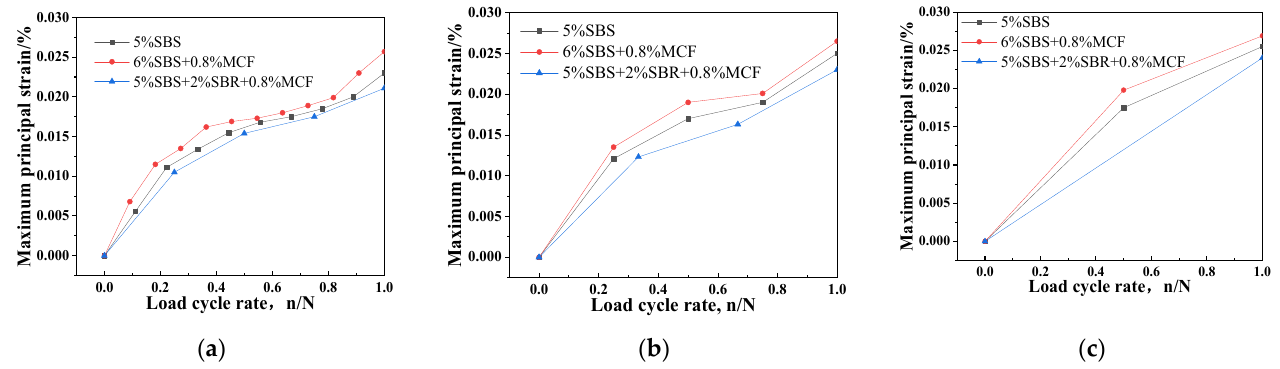
Figure 12. Relationship between maximum principal strain and loading cycle rate: ( a ) Relationship curves under 0.3 stress ratio; ( b ) Relationship curves under 0.4 stress ratio; ( c ) Relationship curves under 0.5 stress ratio.